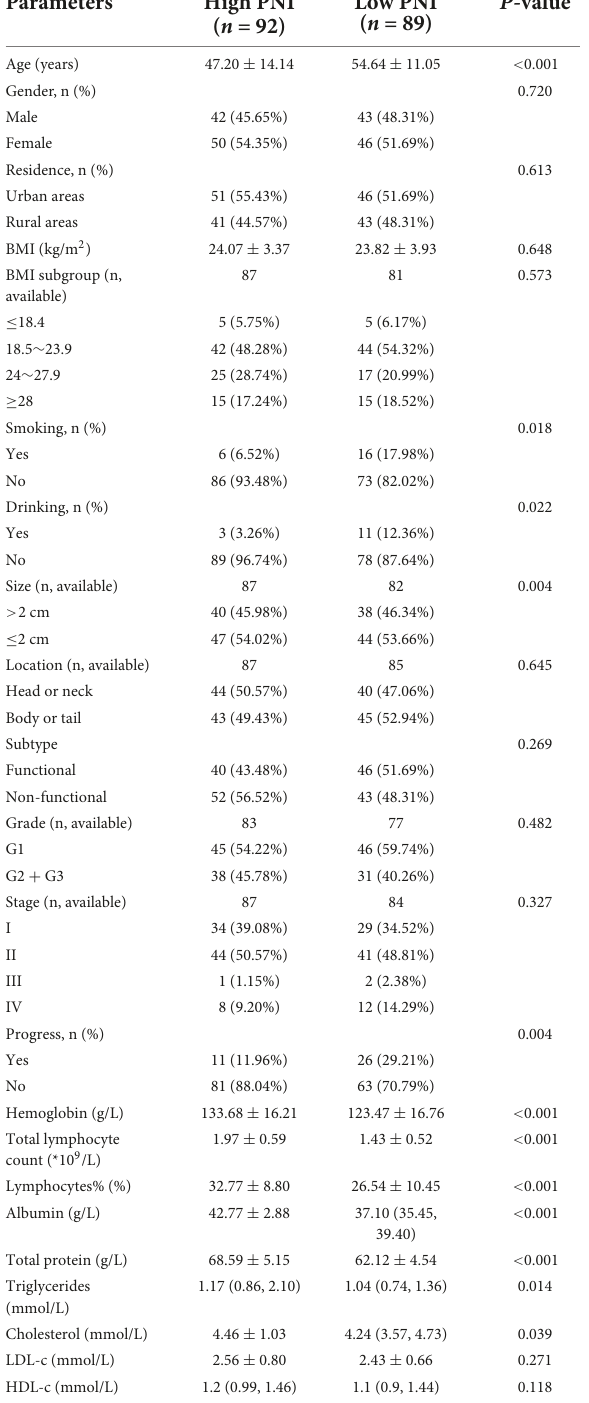
TABLE 2 Associations of PNI with clinicopathologic characteristics of patients with pNENs.